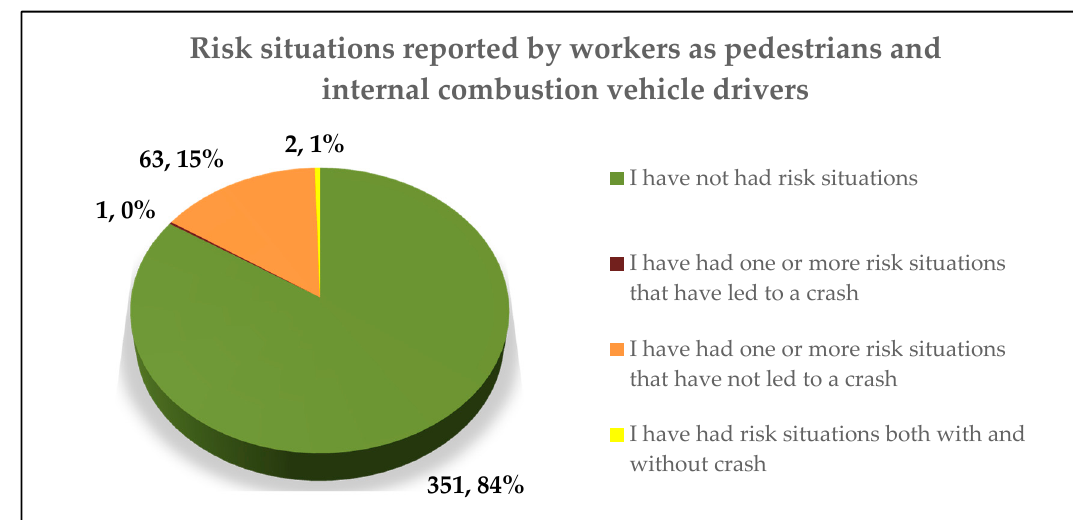
Figure 3. Results of risk situations reported by workers (n = 417).